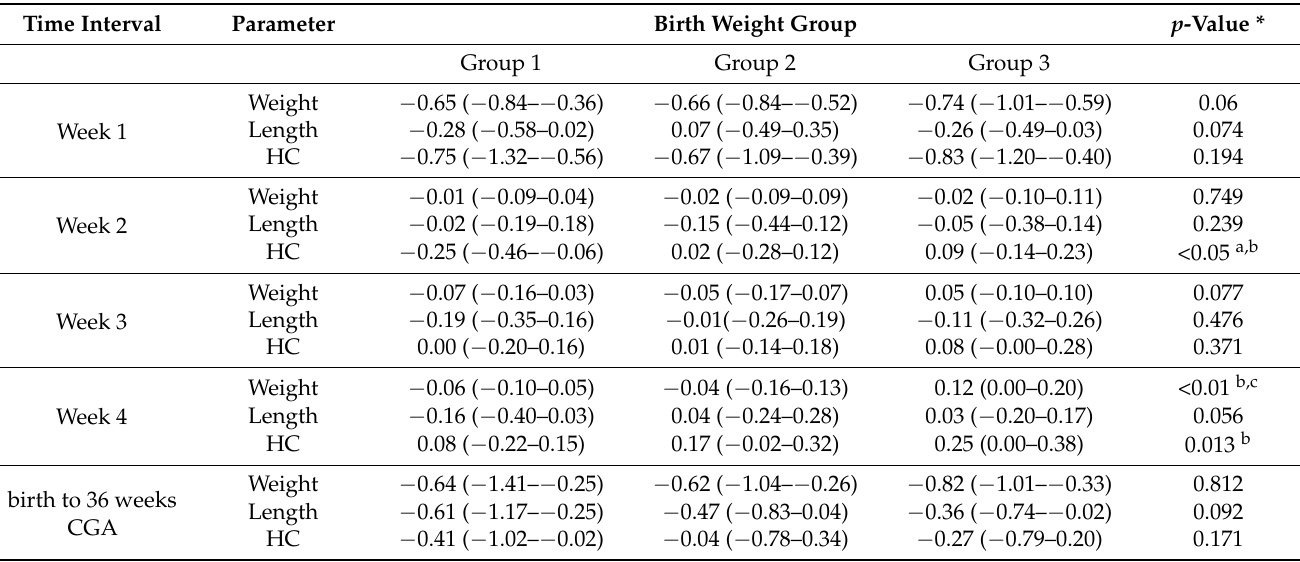
Table 3. Change in z-scores of weight, length, and head circumference (HC) in different birth weight groups from birth to 28 days and 36 weeks CGA or discharge.